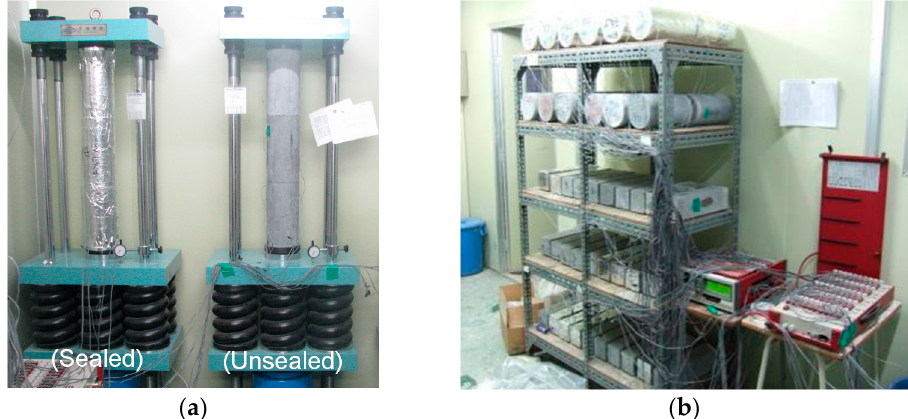
Figure 3. Test overview of high-strength concrete: ( a ) creep test; ( b ) shrinkage test.